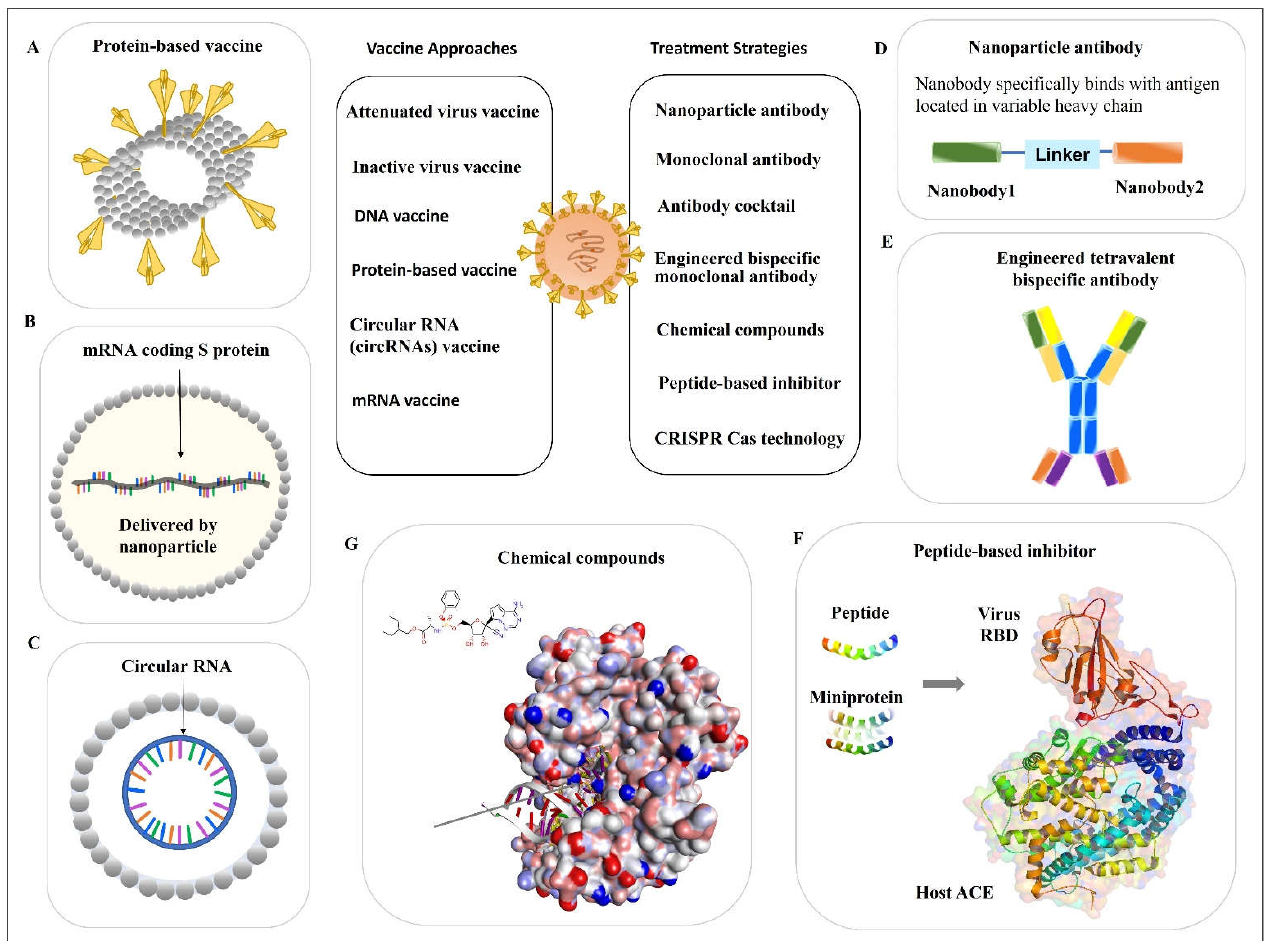
Figure 3. Vaccines and pharmaceutical strategies against SARS-CoV-2 infection. The treatment options for COVID-19 infection are shown in cartoons. Current main treatment options against SARS-CoV-2 infection include ( A ) protein-based vaccines, ( B ) mRNA vaccines, ( C ) circular RNA vaccines, ( D ) nanoparticle antibodies, ( E ) engineered tetravalent bispecific antibodies, ( F ) peptide-based inhibitors (Protein Data Bank/PDB: 6M0J), and ( G ) chemical compounds (PDB: 7BV2). Abbreviations: ACE2: angiotensin-converting enzyme 2; CRISPR/Cas: clustered regularly interspaced short palindromic repeats – associated nucleases; RBD: receptor-binding domain.